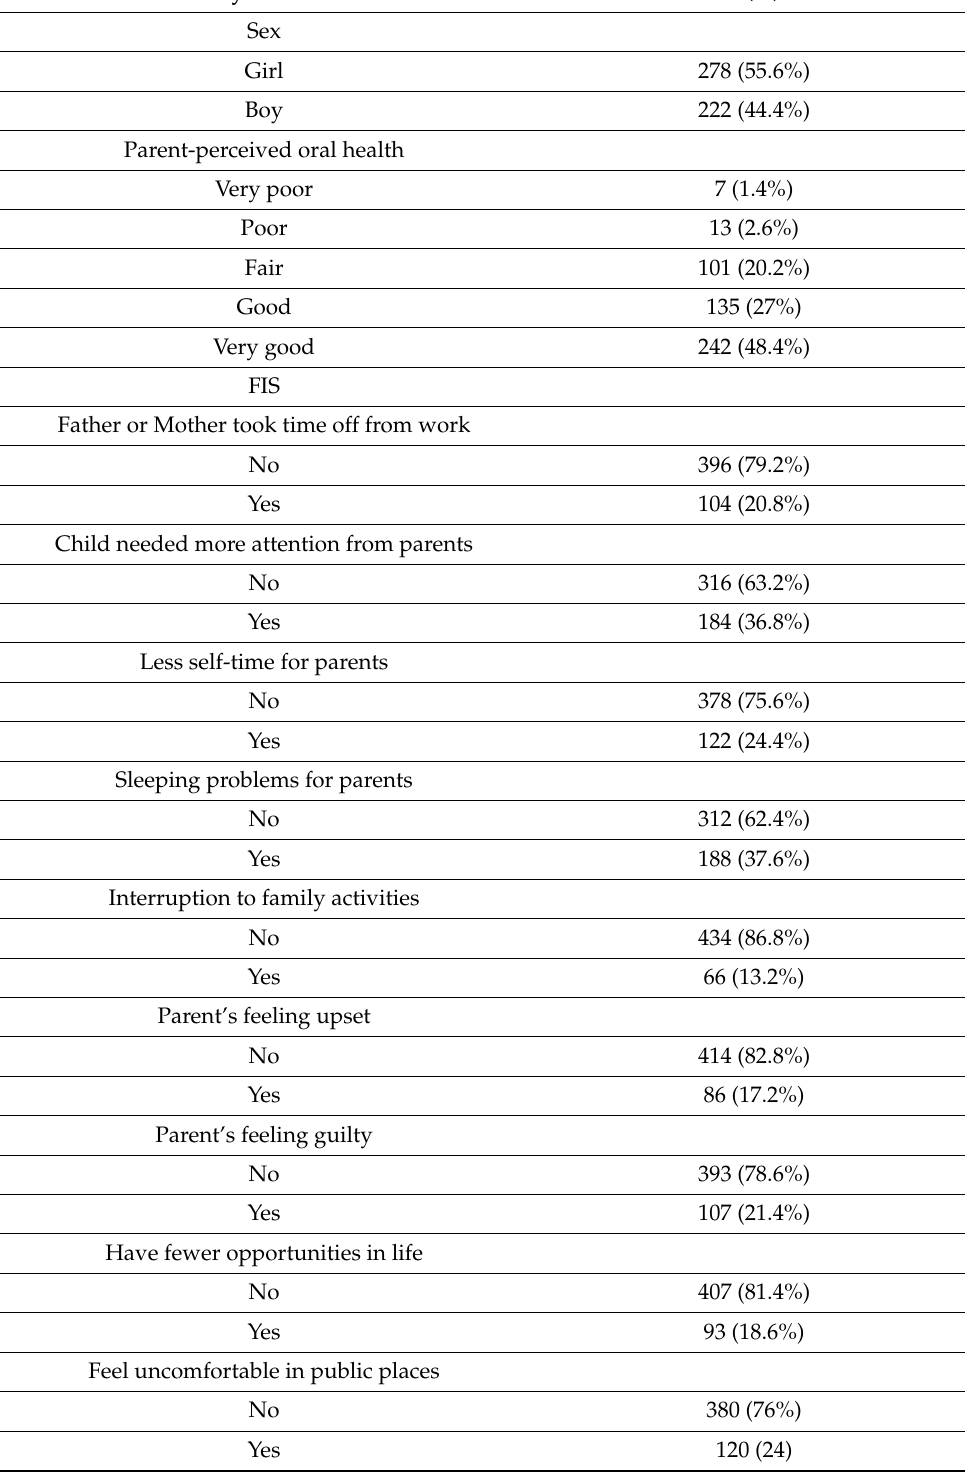
Table 1. Descriptive characteristics of the study sample ( n =